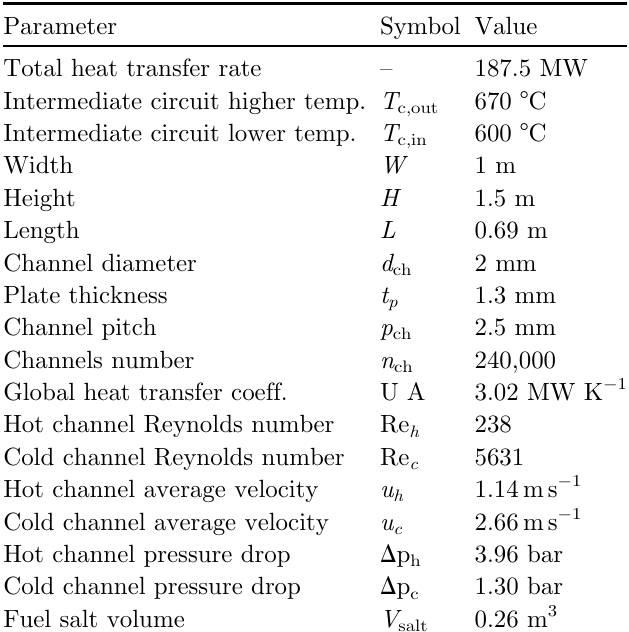
Table 3. Geometric and operational parameters of the